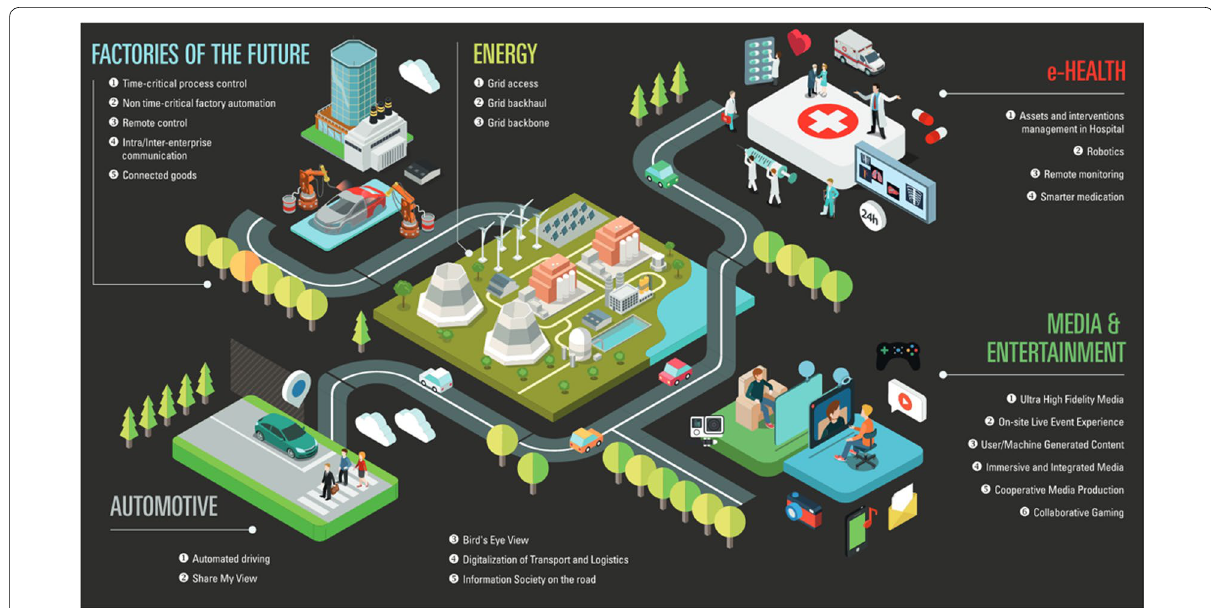
Fig. 7 5G wireless networks applications—Reference Prieto-Cerdeira et al.